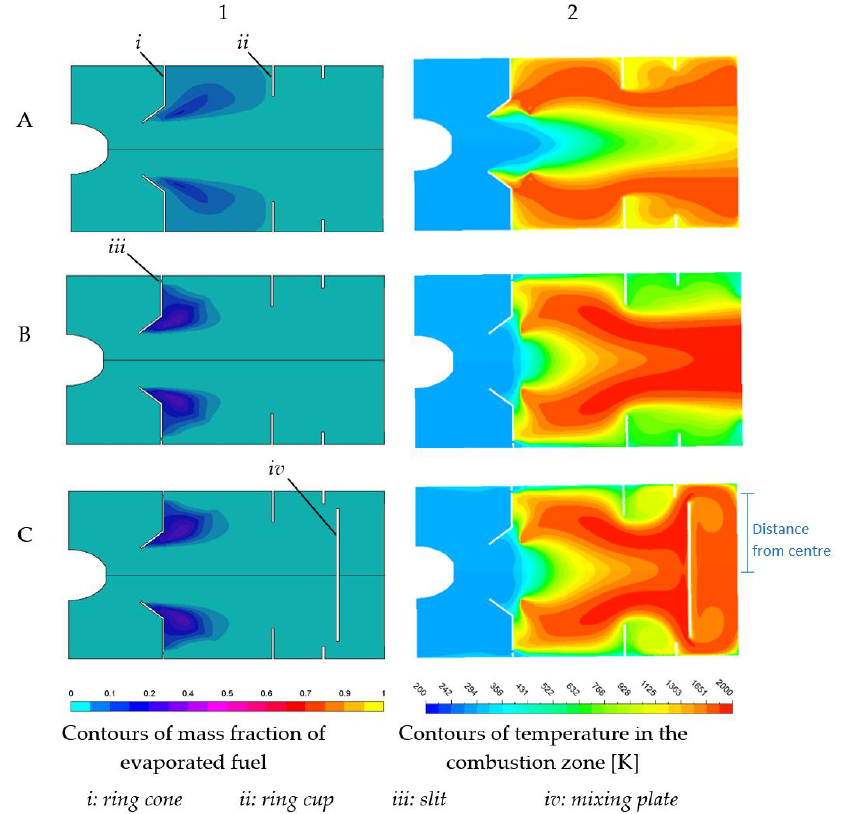
Figure 5. Contours of mass fraction of fuel ( column 1 ) and temperature ( column 2 ) for three geometry cases ( A–C ).